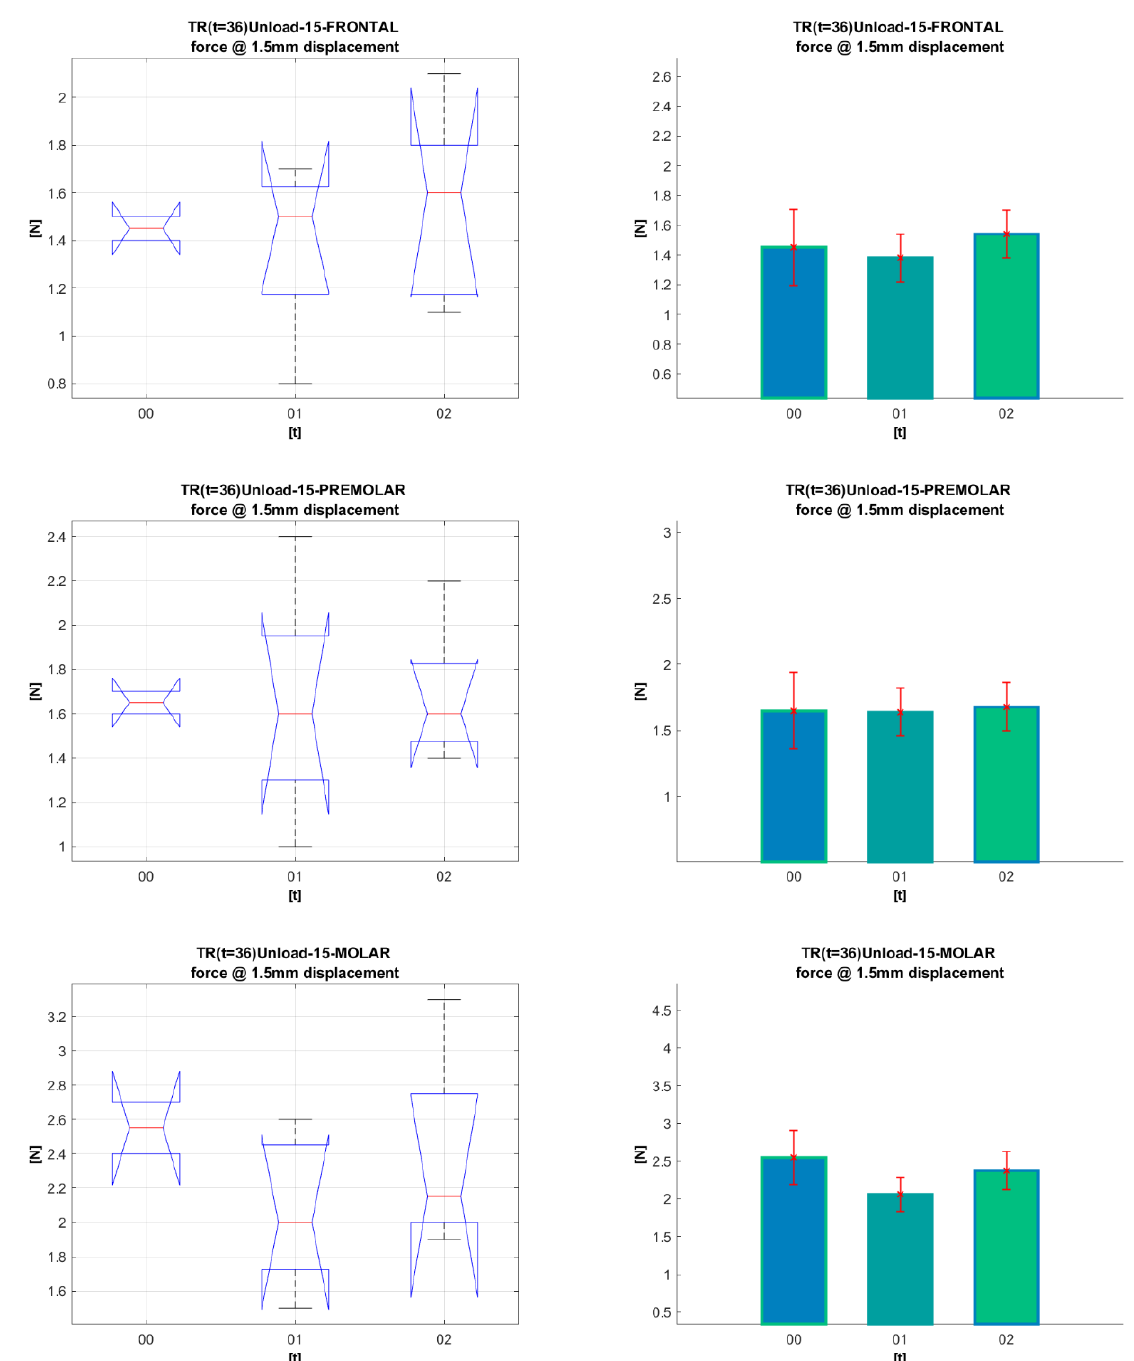
Figure 9. Statistical analysis for 1.5 mm deformation of TriTanium ® archwires for periods (G 0 , G 1 , G 2 ).